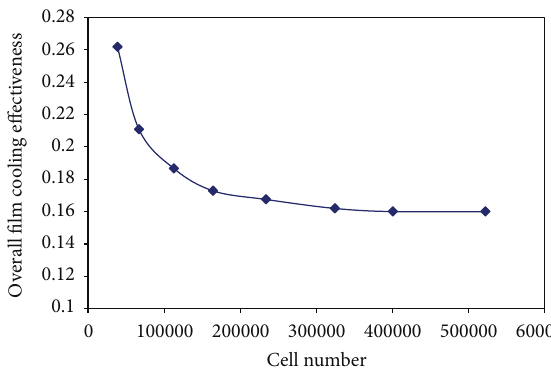
Figure 9: Variation of the average film cooling effectiveness with the grid size for 𝑀 = 1